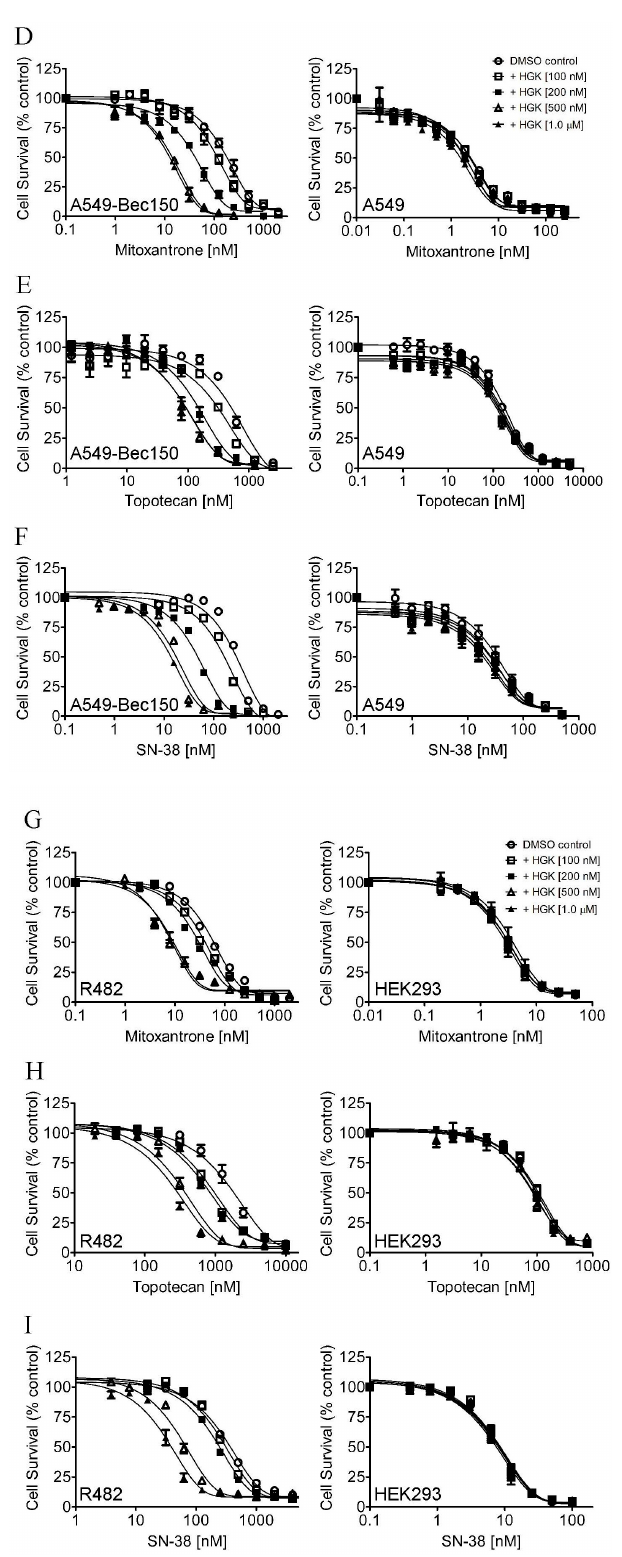
Figure 3. Cytotoxicity of ABCG2 substrate drugs in the absence or presence of hydroxygenkwanin. The cytotoxicity of mitoxantrone, topotecan, and SN-38 was determined in ( A – C ) NCI-H460/MX20 and NCI-H460, ( D – F ) A549-Bec150 and A549, and ( G – I ) R482-HEK293 and pcDNA3.1-HEK293 cells in the presence of DMSO (open circles) or hydroxygenkwanin (HGK) at 100 nM (open squares), 200 nM (filled squares), 500 nM (open triangles), or 1.0 µ M (filled triangles) as described in the Section 4. Points, mean values from at least three independent experiments; bars;